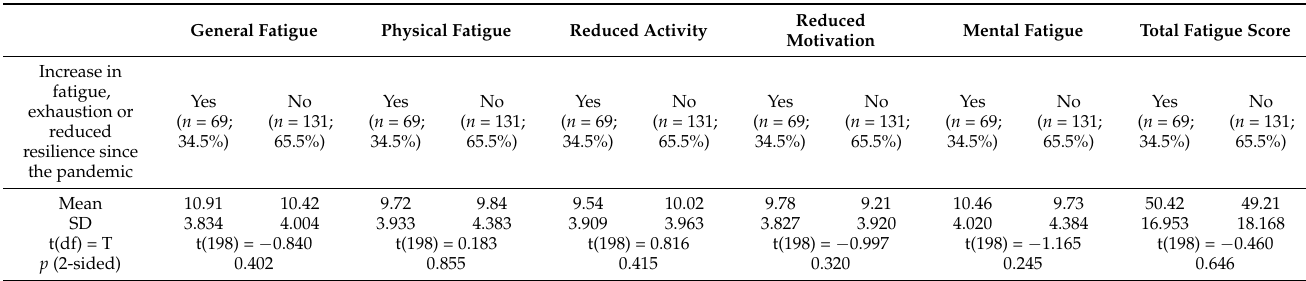
Table 2. Differences between fatigue scores of the group experiencing an increase in fatigue since the pandemic and the group that reported no difference in context of the pandemic. ( n = 200).